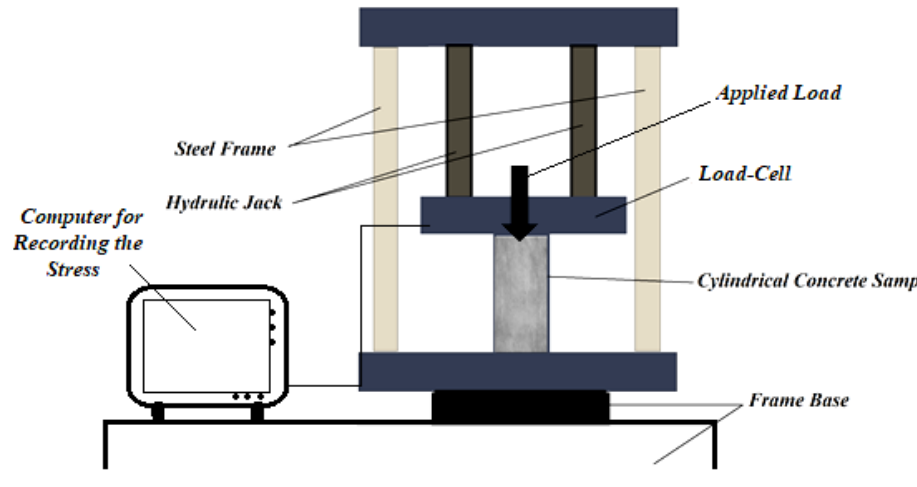
Figure 4. Used setup to determine compressive and tensile resistances.